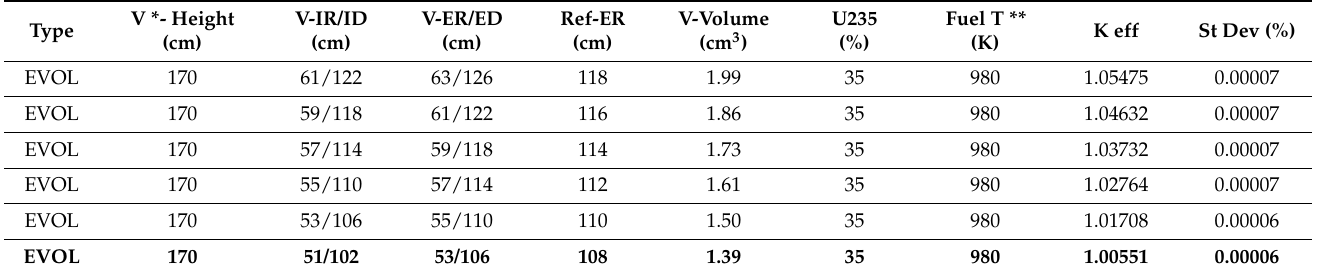
Table 8. Criticality search results for EVOL salt fuel system.